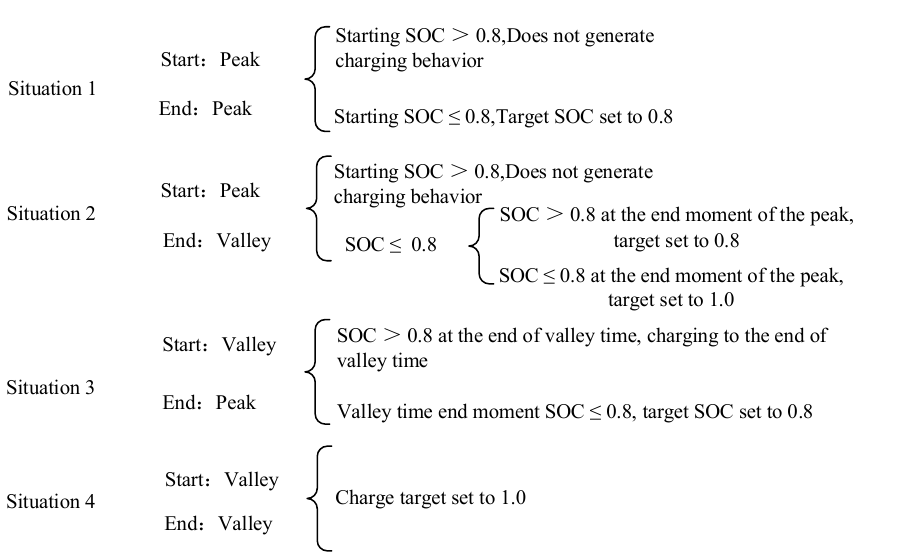
Figure 1. Dynamic correction method of electric vehicle charging target under peak-to-valley electricity price.